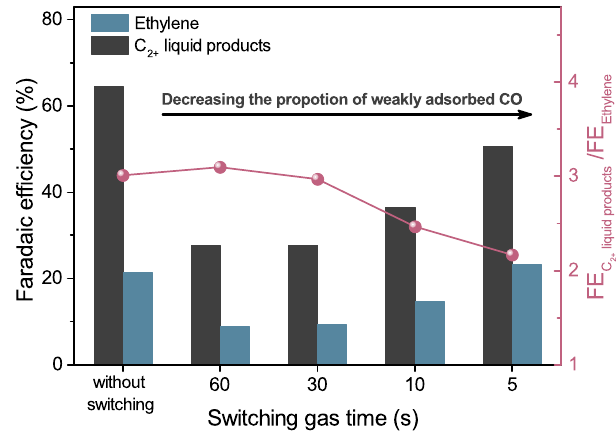
Fig. 3 | Electrolysis in the switching CO/Ar atmosphere on Cu(OD) 0.8 Ag 0.2 . Faradaic ef fi ciency of multi-carbon liquid products and ethylene. The red circles showthecorrespondingFaradaicef fi ciencyratioofmulti-carbonliquidproductsto ethylene. Constant current electrolysis at 100mAcm − 2 is conducted on Cu(OD) 0.8 Ag 0.2 withswitchinginletgasbetweenCOandAratdifferentfrequencies (switch CO/Ar every 60, 30, 10, 5, and